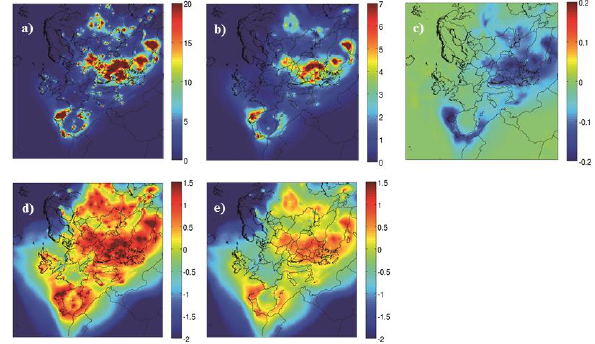
1044 1045 Fig. 6: Predicted average fractional increase in number concentration due to nucleation for the 1046 Fig. 6. Predicted average fractional increase in number concentra- baseline 2030 scenario for N tot (a), N 10 (b), N 100 (c), log 10 of the increase in N tot (d), and log 10 1047 of the increase in N 10 (f). 1048 tion due to nucleation for the baseline 2030 scenario for N tot (a) , N 10 (b) , N 100 (c) , log 10 of the increase in N tot (d) , and log 10 of the increase in N 10 (e)